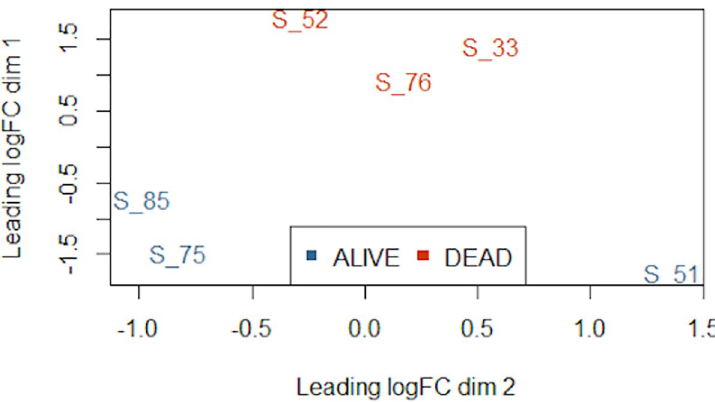
Fig 1. Multidimensional scaling of RNA expression at arrival identifies expression clustering in cattle that die of BRD.